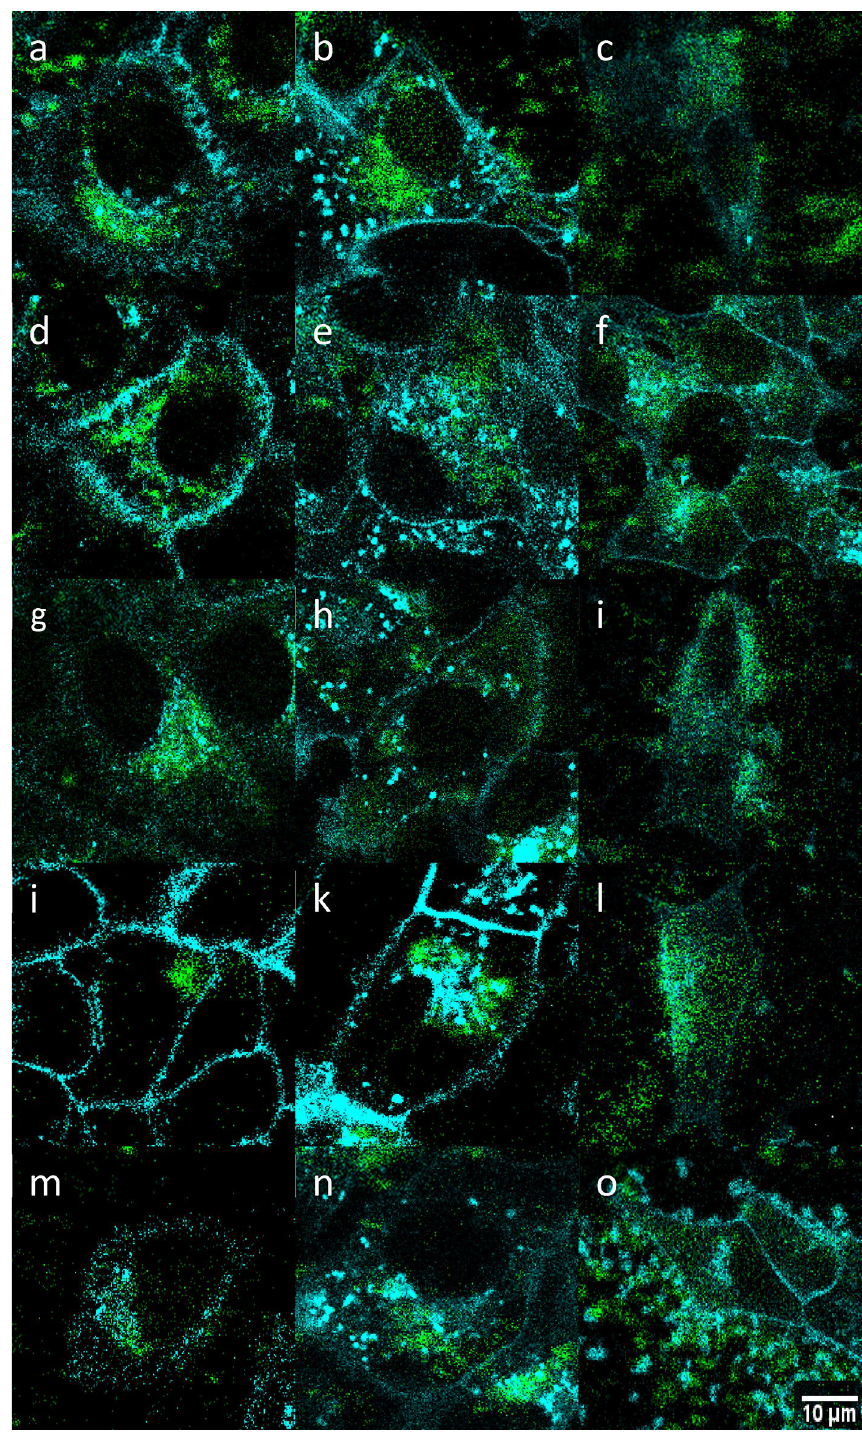
Figure 7. Detailed confocal micrographs showing distribution of ( a – c ) CS-UCNP, ( d – f ) CS-UCNP@Ner-PEG, ( g –i) CS-UCNP@Ale-P(DMA-AEC)-DY-615, ( j – l ) CS-UCNP@Ale-PDMA-DY-615, and ( m – o ) CS-UCNP@ Ale-P(DMA-AMPS)-DY-615 (1–1.7 mg/ml) in ( a , d , g , j , m ) HeLa, ( b , e , h , k , n ) Hep-G2, and ( c , f , i , l , o ) INS-1E cells after excitation at 980 nm (laser power 30–50 mW); cell membranes are blue and nanoparticles are green. CS-UCNP—NaYF 4 :Yb,Er@NaYF 4